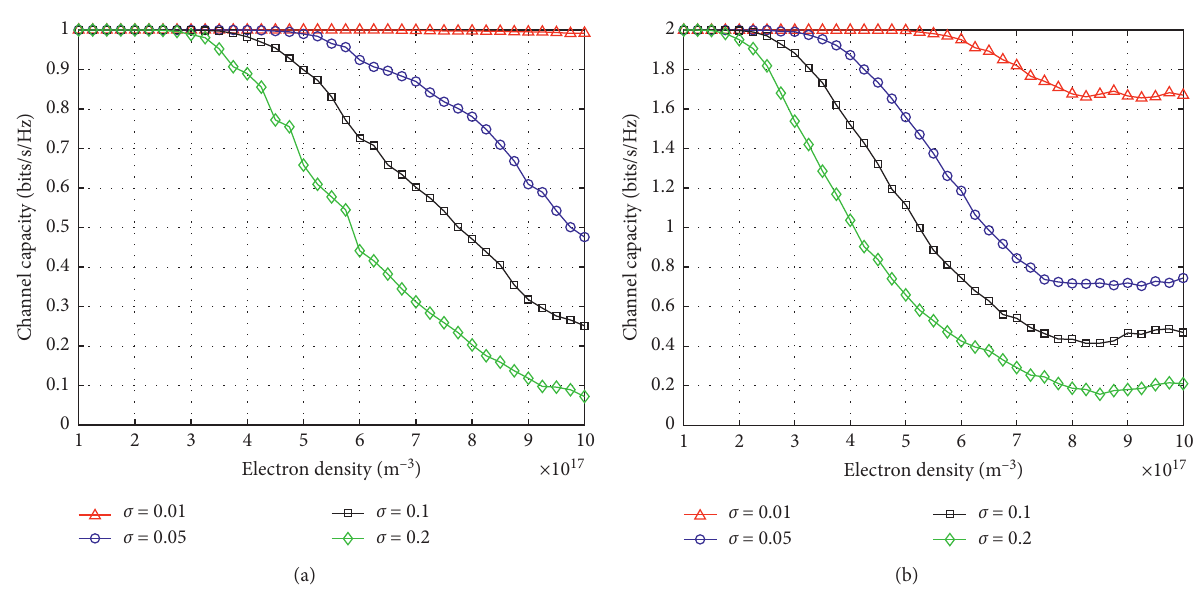
on channel capacity. (a) BPSK, (b) QPSK. en